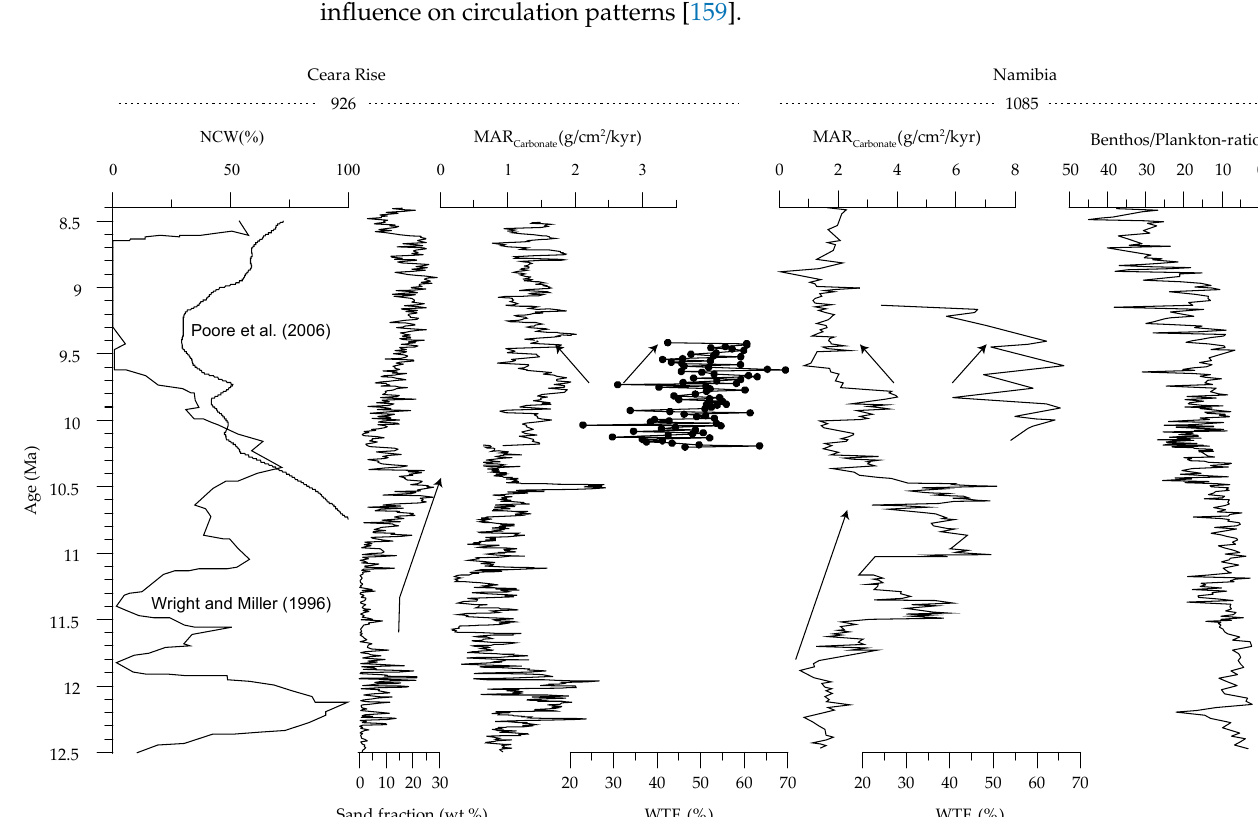
Figure 6. The Atlantic exhibits in general a preservation pattern in accordance with Northern Component Water (NCW) formation, but the decreasing NCW% estimate (centred at about 9.25 Ma) is not accompanied by decreasing but by increasing preservation in the deep Atlantic as shown by the sand and whole foraminifera tests (WTF) contents. Site 1085 preservation is decreasing at about 9.5 Ma showing a different preservation pattern to the deep Atlantic, but possibly both sites suffered from productivity decreases of calcareous nannoplankton (in this phase preservation increases and MAR decreased [125].